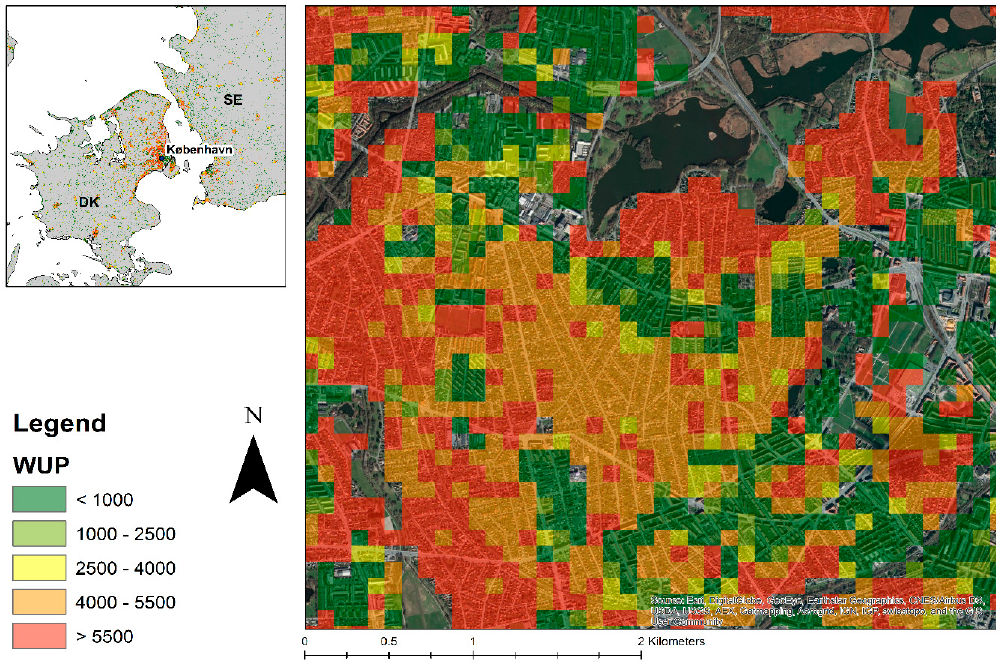
Figure 1. Weighted Urban Proliferation (WUP) values for LUISA population 2010 reference scenario, using a 2 km horizon of perception for a suburb of Copenhagen, Denmark. Densely populated places (apartments) show low WUP values while less populated “suburb” areas (typically house and garden) are associated with higher WUP values.